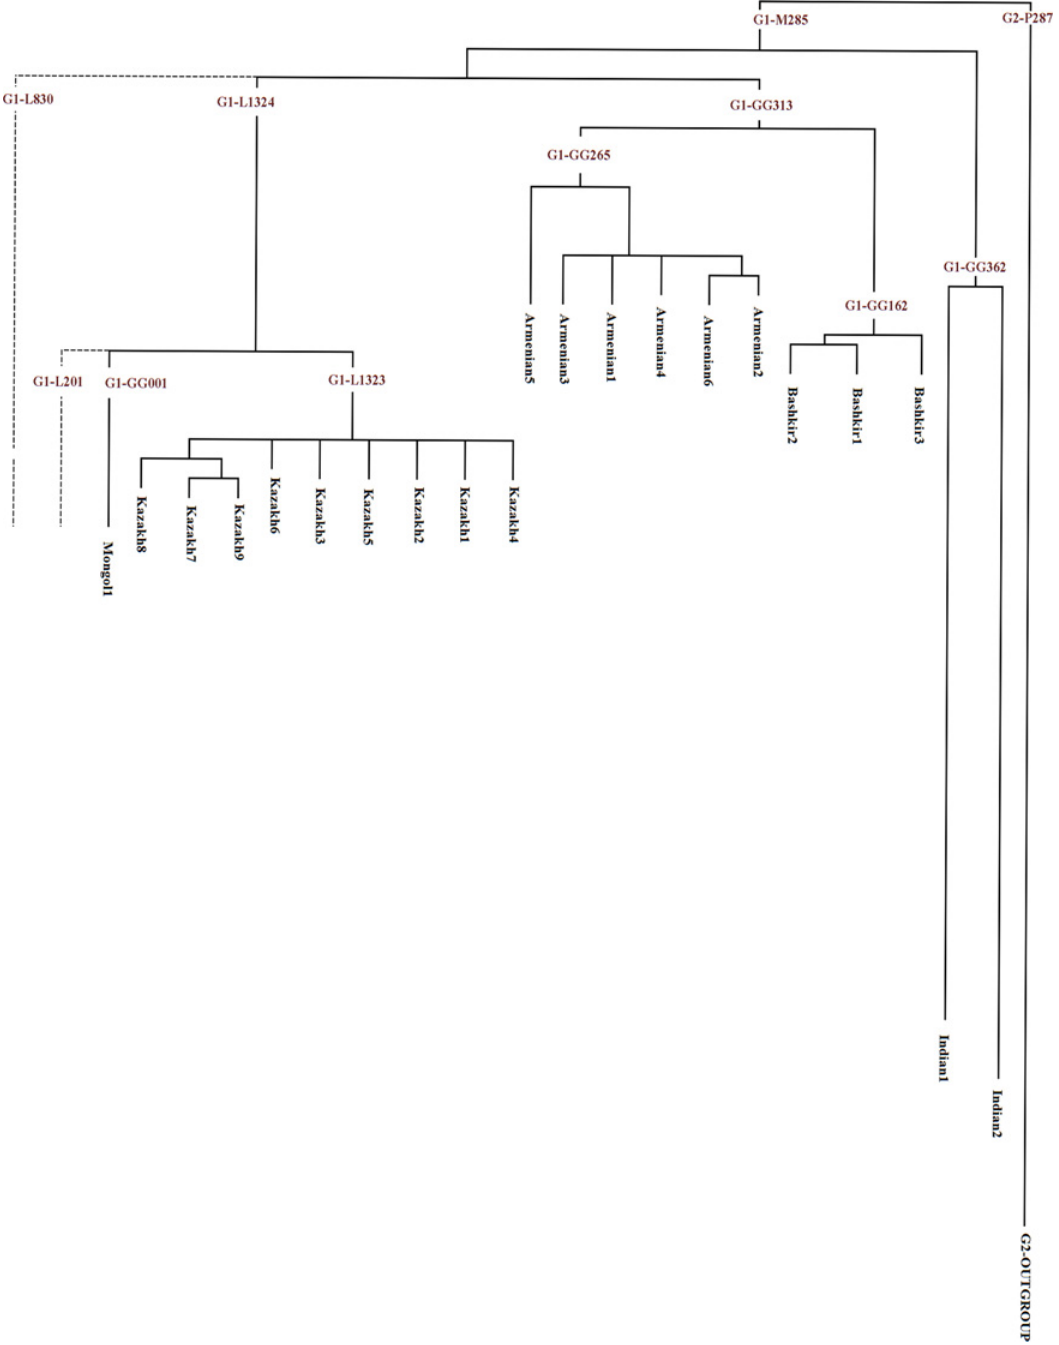
Fig 5. Y-chromosome haplogroup G1 phylogeny. The tree combines the high-coverage dataset reported in this study with data from 1000 Genomes Project. Dotted lines indicate the approximate phylogenetic position of two previously reported G1 branches which were absent among our samples.